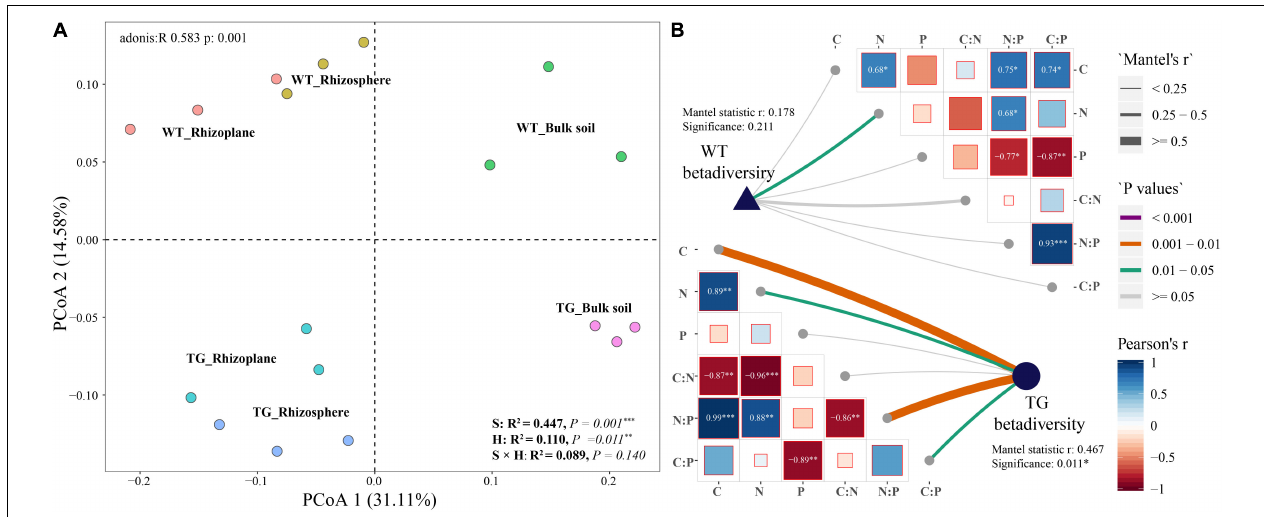
FIGURE 2 | (A) Principal coordinate analyses (PCoAs) using Bray distance metric indicates that the largest separation between bacterial communities is spatial distribution of three areas (PCoA.1) and the second largest source of variation is cultivar (PCoA.2). (B) Correlation between environmental factors and correlation between bacterial beta-diversity and environmental factors in two sugarcane cultivars using Mantel test.